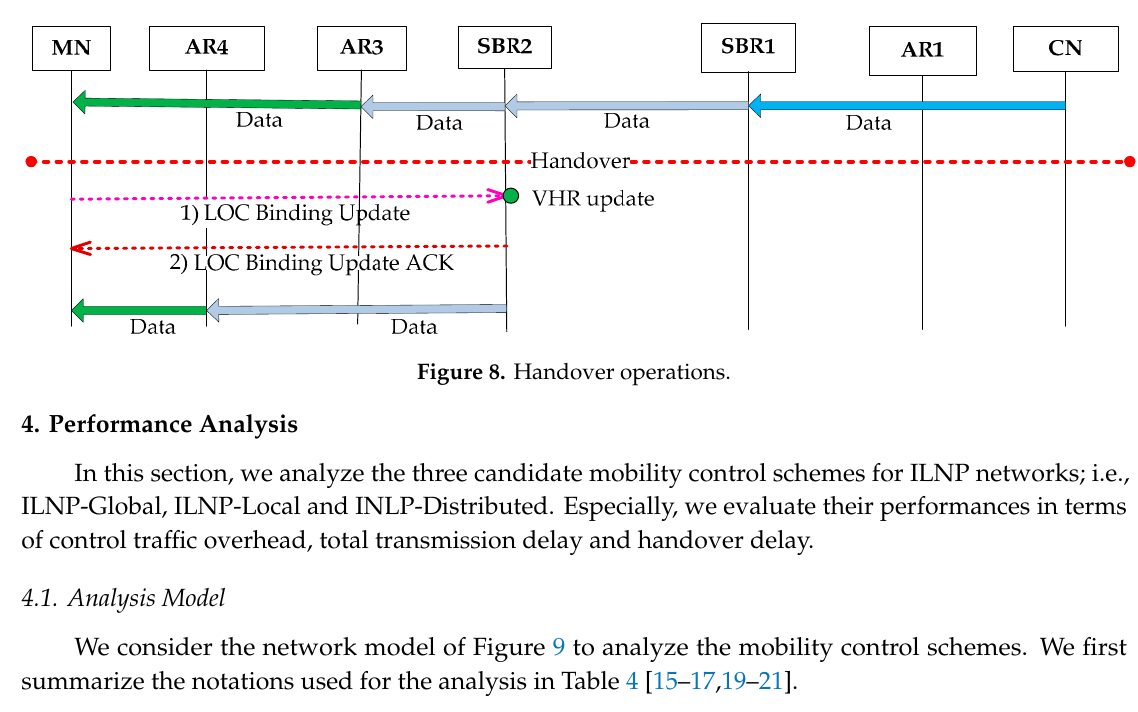
Figure 7. Binding and query operations for roaming.